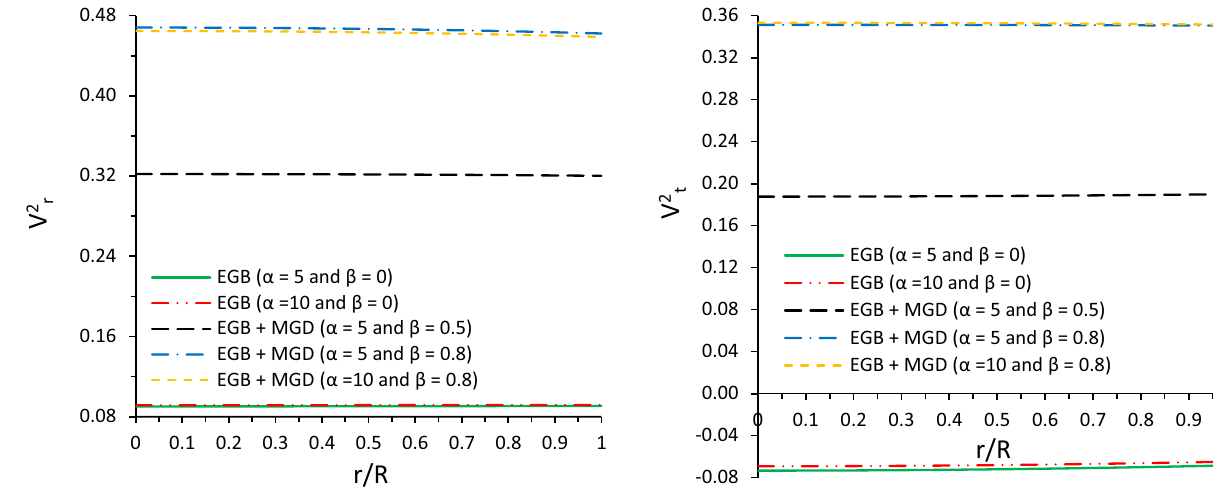
Fig. 10 The variation of sound speed versus radial coordinate r / R for solution B that the radial pressure will be greater in magnitude than the seed radial pressure. Consequently, the anisotropic fac- tor will increase in magnitude too. On the other hand, when (solution B) the situation the seed density ˆ ρ is equal to θ 0 0 becomes more interesting. In this case, as the total density is proportional to the seed one by a factor of ( 1 + β) , the system becomes denser and more compact when β > −